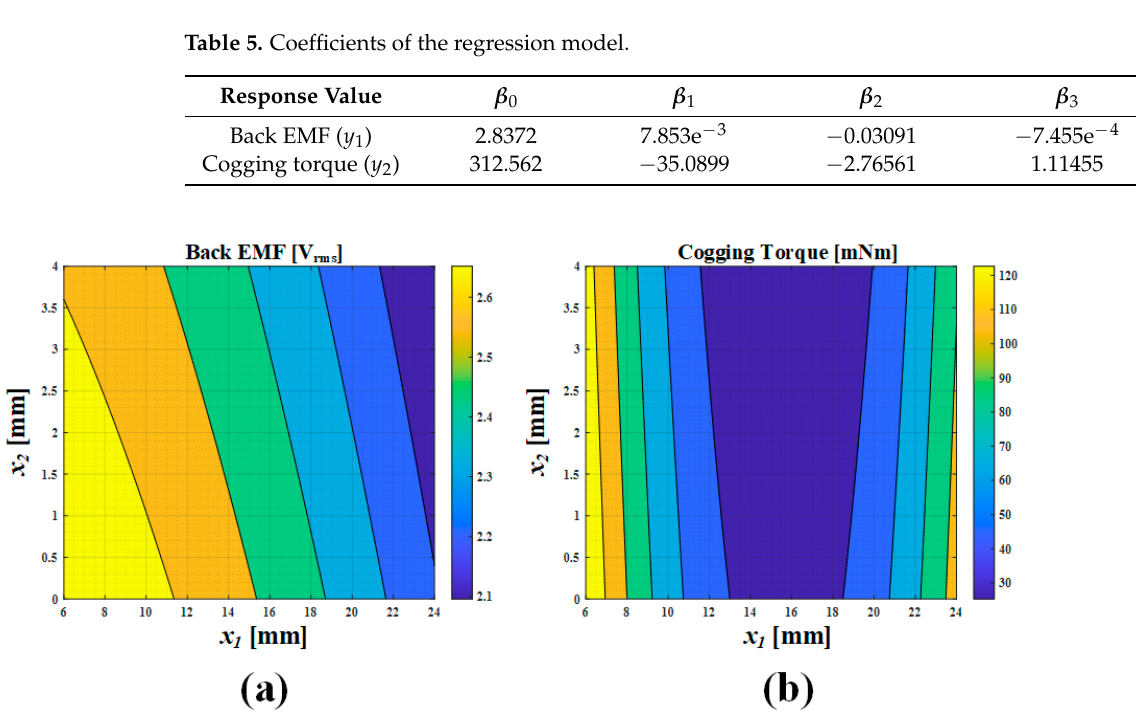
Figure 6. Contour plot: ( a ) Back EMF and ( b ) cogging torque.